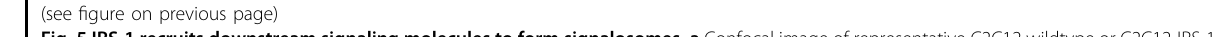
Fig. 5 IRS-1 recruits downstream signaling molecules to form signalosomes. a Confocal image of representative C2C12 wildtype or C2C12-IRS-1 KO cells stably expressing mCherry-p85. Scale bar, 10 µm. Quanti fi cation results of mCherry-p85 puncta are shown and presented as violin plots. **** p < 0.0001. b Puri fi ed mCherry, mCherry-tagged p85 or Grb2 (1 μ M) was incubated with iFluor ™ 488-FLAG-mIRS-1 (1 μ M) for 5 min. Scale bar, 20 µm. c Confocal images of endogenous p85 and GFP-mIRS-1 or mutants in the indicated cell lines. Scale bar, 10 µm. Line scan showing the related intensity pro fi les of mIRS-1 with p85. Scale bar, 10 µm. The GFP-positive puncta co-localized with p85 was quanti fi ed ( n = 33). Data in the bar graphs represent the mean ± SEM. **** p < 0.0001. d GFP-tagged mIRS-1 wildtype or mutants were immunoprecipitated in IGF-1-stimulated or control C2C12-IRS-1 KO, C2C12-IRS-1 KO/GFP-mIRS-1, C2C12-IRS-1 KO/GFP-mIRS-1 Δ SAR or C2C12-IRS-1 KO/GFP-mIRS-1 9YA cell lines and then subjected to Western blot with p85 or Grb2 antibodies. Data in the bar graphs represent the mean ± SEM values of the ratios of densities for three independent experiments. **** p < 0.0001. e Immunoblot analysis of total and phosphorylated AKT and ERK levels in C2C12 wildtype, C2C12-IRS-1 KO, C2C12-IRS-1 KO/GFP-mIRS-1, C2C12-IRS-1 KO/GFP-mIRS-1 Δ SAR or C2C12-IRS-1 KO/GFP-mIRS-1 9YA cell lines treated with or without IGF-1 conditional medium for 2.5 min. Data in the bar graphs represent the means ± SEM values of the ratios of densities for three independent experiments. *** p < 0.001. **** p < 0.0001. ns not signi fi